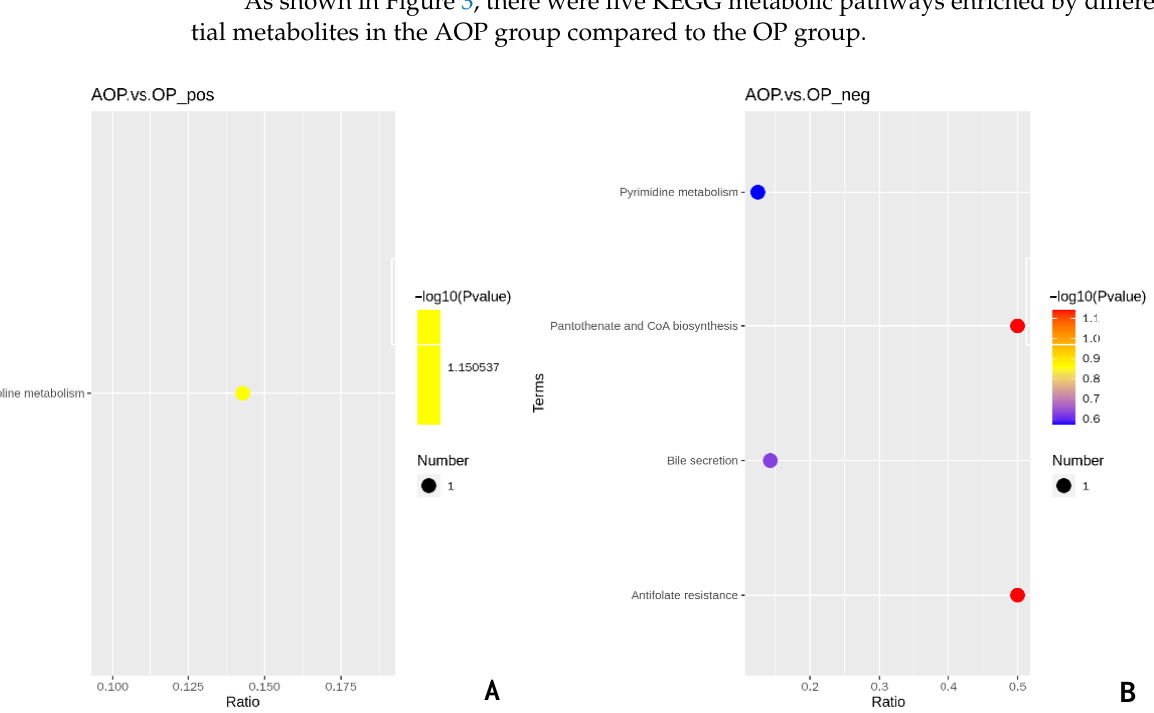
Table 7. A comparison of the concentrations of metabolites in pancreas tissue from yak calves fed alfalfa and oat hay or oat hay.